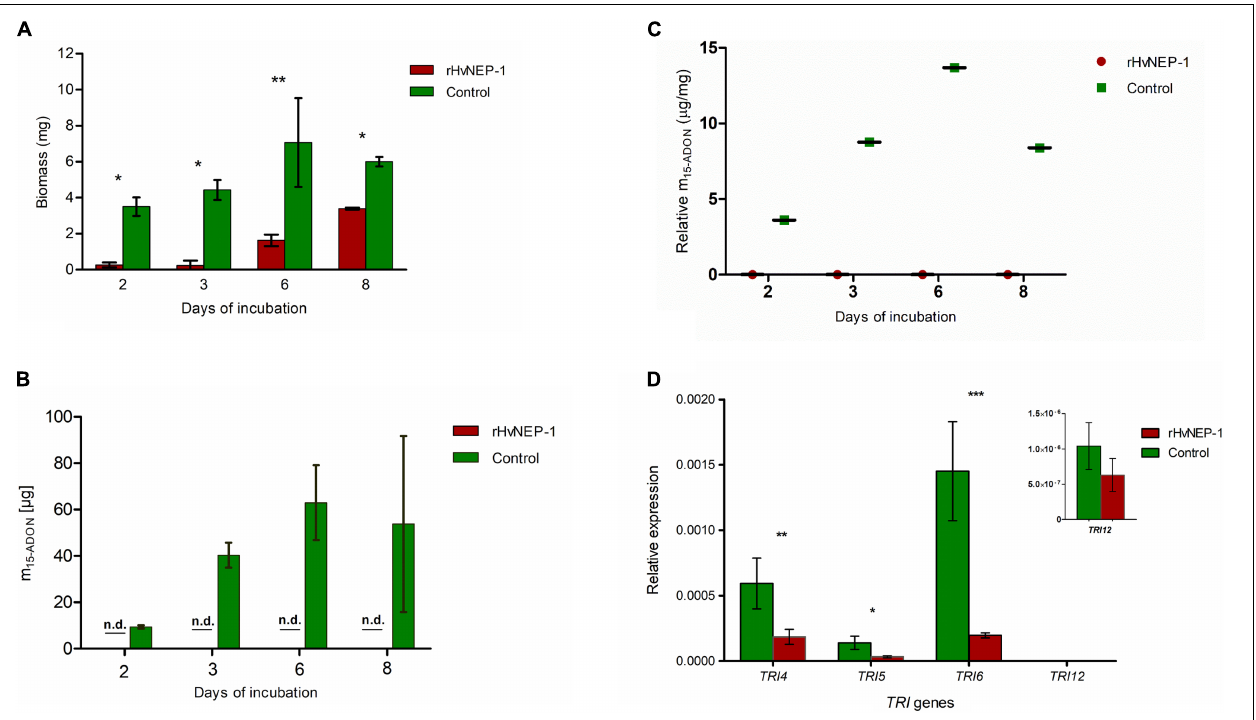
FIGURE 5 | Effects of rHvNEP-1 on the biomass and mycotoxin accumulation of Fusarium fungi. (A) Comparative analysis of biomass accumulation of F. graminearum strain JCM9873 with and without rHvNEP-1. (B) In vitro accumulation of 15-ADON in F. graminearum JCM9873 strain in the presence and absence of rHvNEP-1. n.d. denotes for toxin below detection level in the rHvNEP-1-incubated cultures. Values in (A–C) are the mean of three independent technical replicates. (C) Relative accumulation of 15-ADON to fungal biomass. It is calculated from the mean of 15-ADON and fungal biomass for the sampling day. (D) Quantitative PCR (qPCR) analysis of TRI genes isolated from F. graminearum JCM9873 strain cultured with and without rHvNEP-1. Values are the mean of three independent biological replicates. Error bars in (A–D) = mean ± SE ( n = 3). * p < 0.05, ** p < 0.01, and *** p <